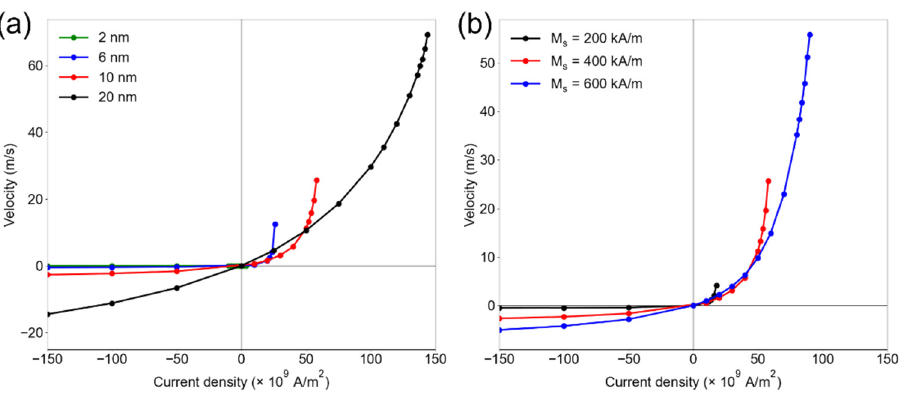
Figure 3. Velocity vs. current density for varying ( a ) t and ( b ) M s . Increasing t or M s result in larger maximum velocities and increased current densities necessary for switching. Results are shown for M Y = −1 .